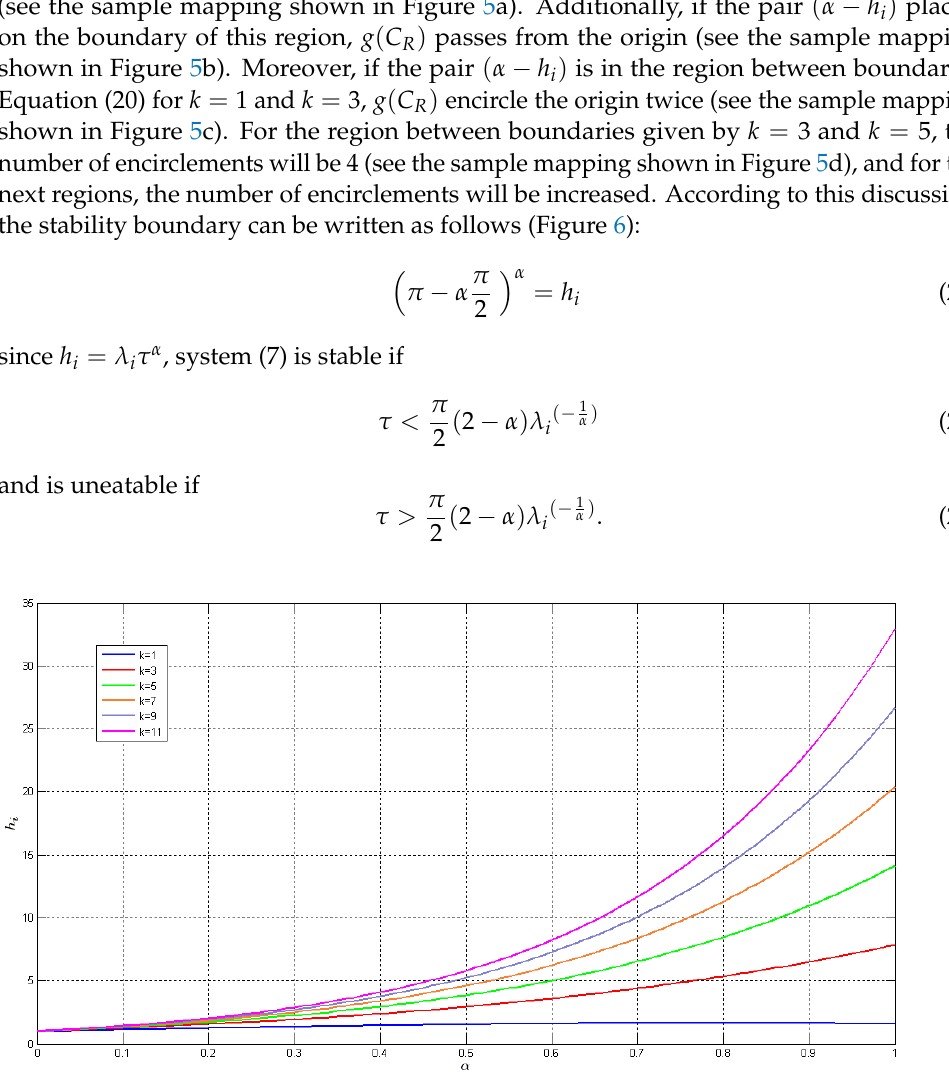
Figure 4. Boundaries specified by Equation (19) for different values of k in the α − h i